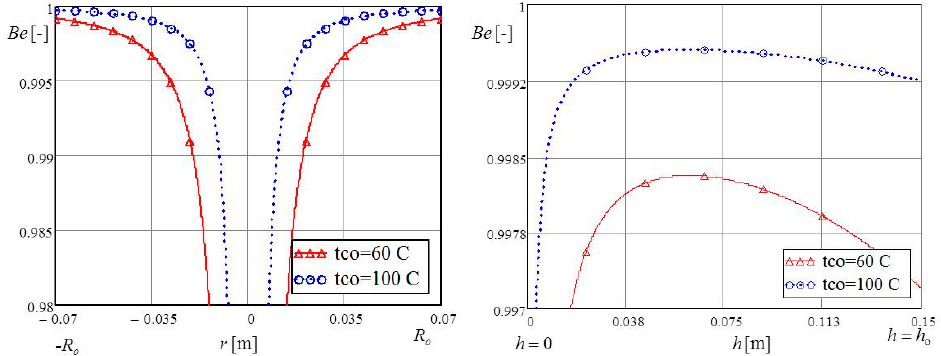
Figure 8. Bejan number of the individual influence of the bottom and the vertical annular